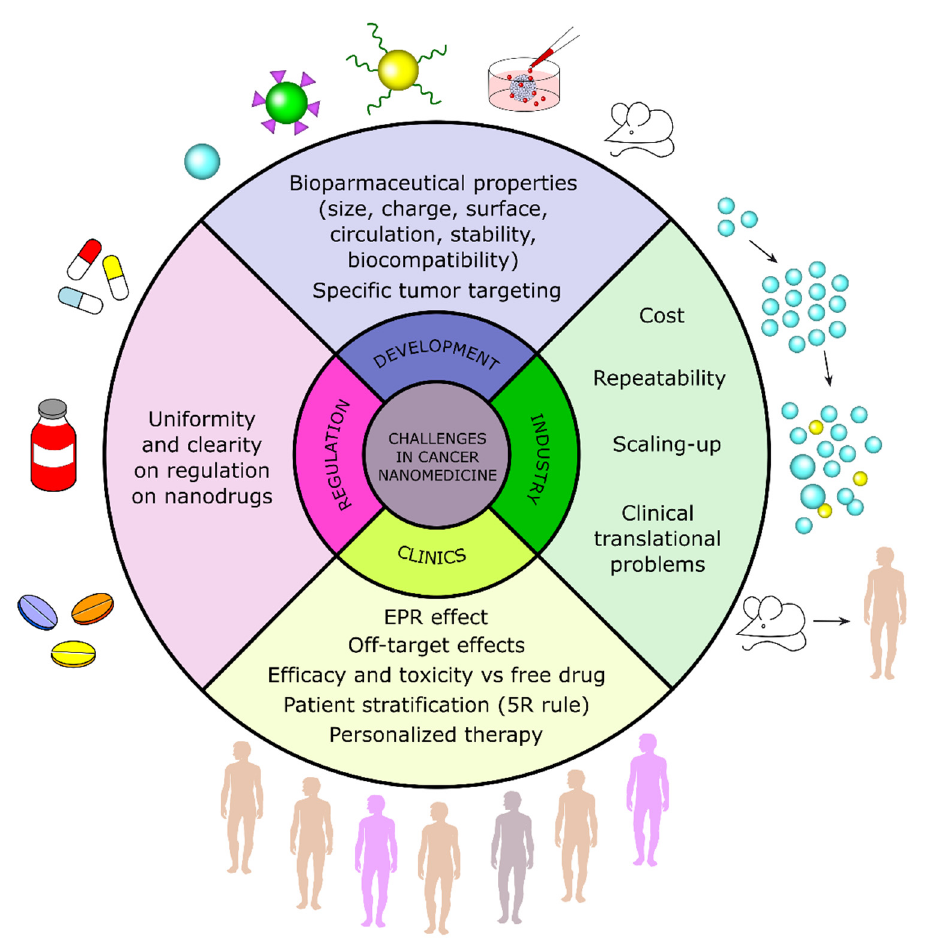
Figure 3. The main challenges toward drug delivery systems in anticancer therapy.